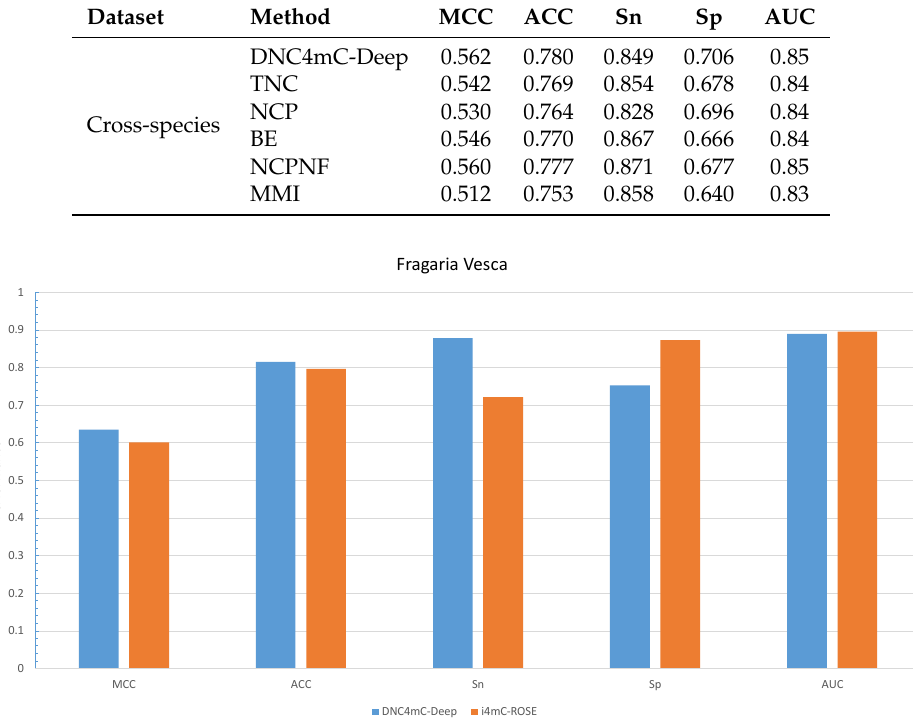
Figure 7. Grapical illustration of performance comparison between DNC4mC-Deep and state-of-the-art model on the independent Fragaria Vesca dataset.